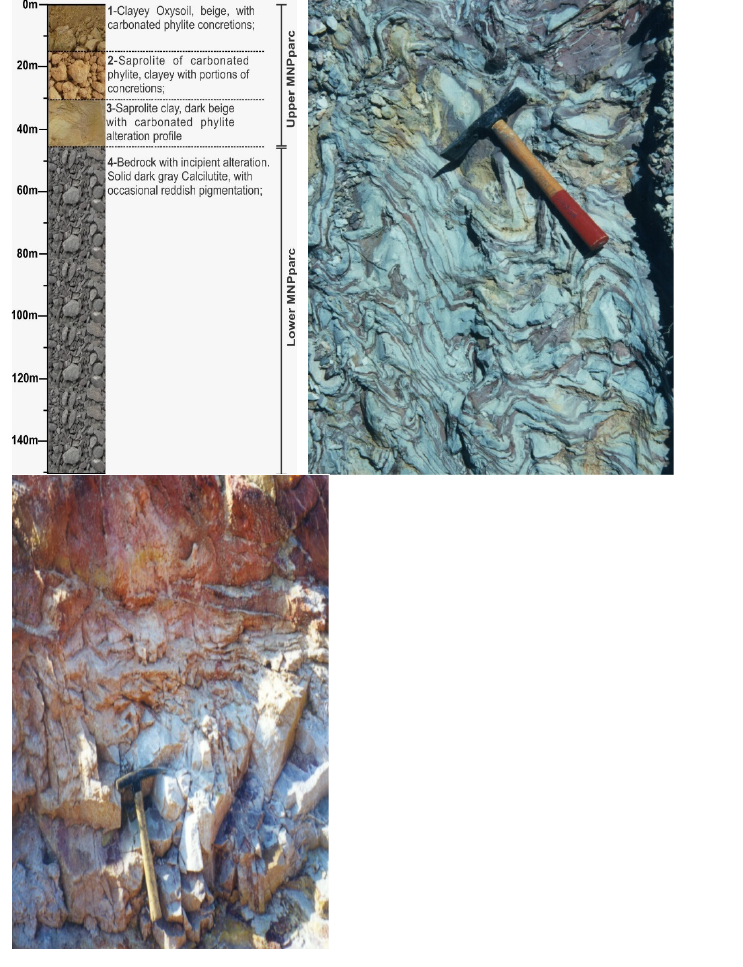
Figure 4. Synthesized lithological log of the area and photographs of the rock outcrops in the fractured aquifer system of Brasilia.